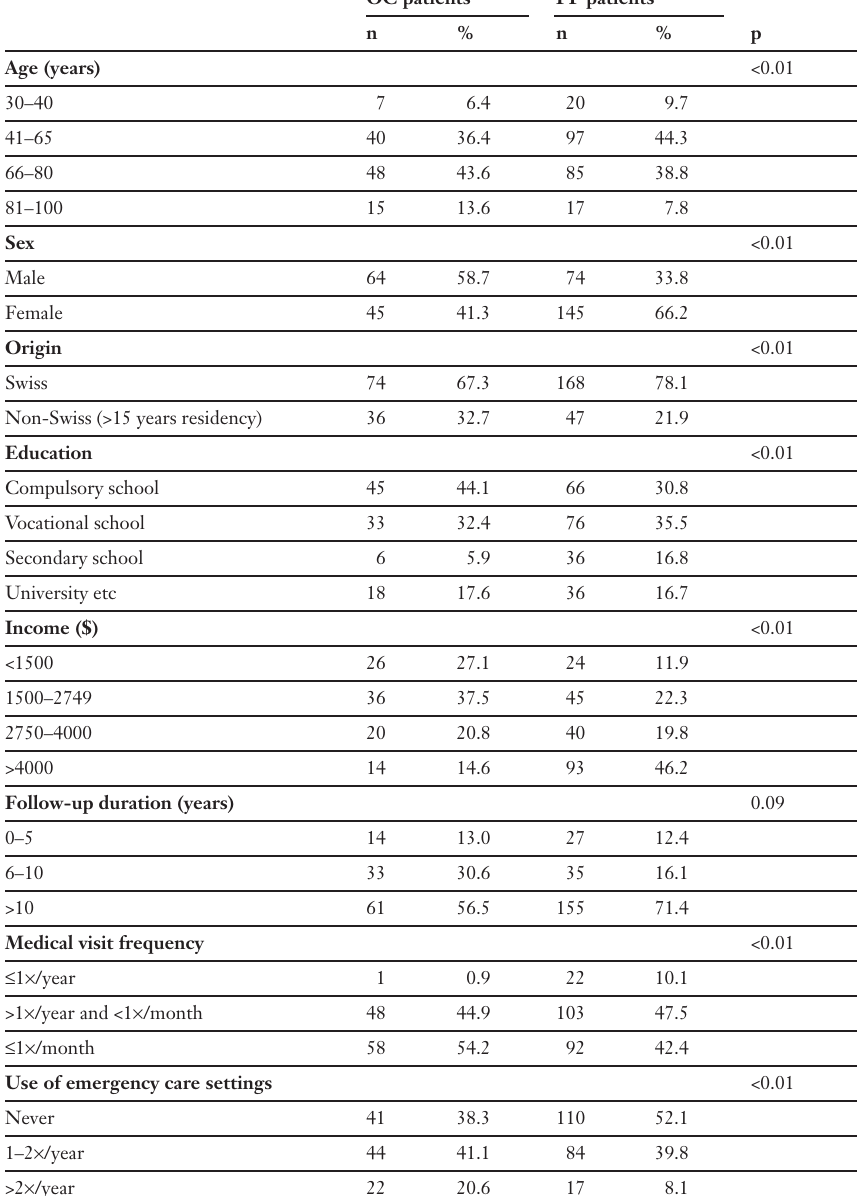
Sociodemographic data and use of med- ical sources among university medical outpatient clinic (OC) patients and private practice (PP)